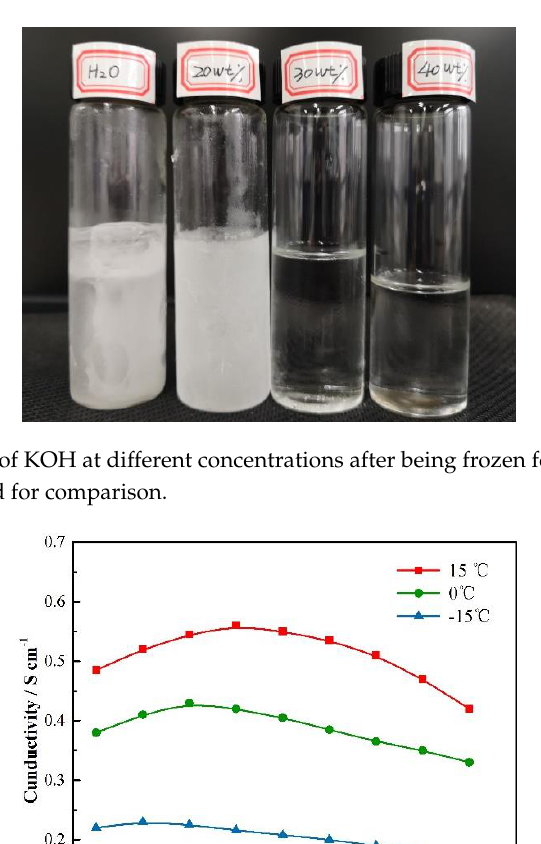
Figure 2. Photographs of KOH at different concentrations after being frozen for 24 h at −25 °C. Pure water on the left is used for comparison.